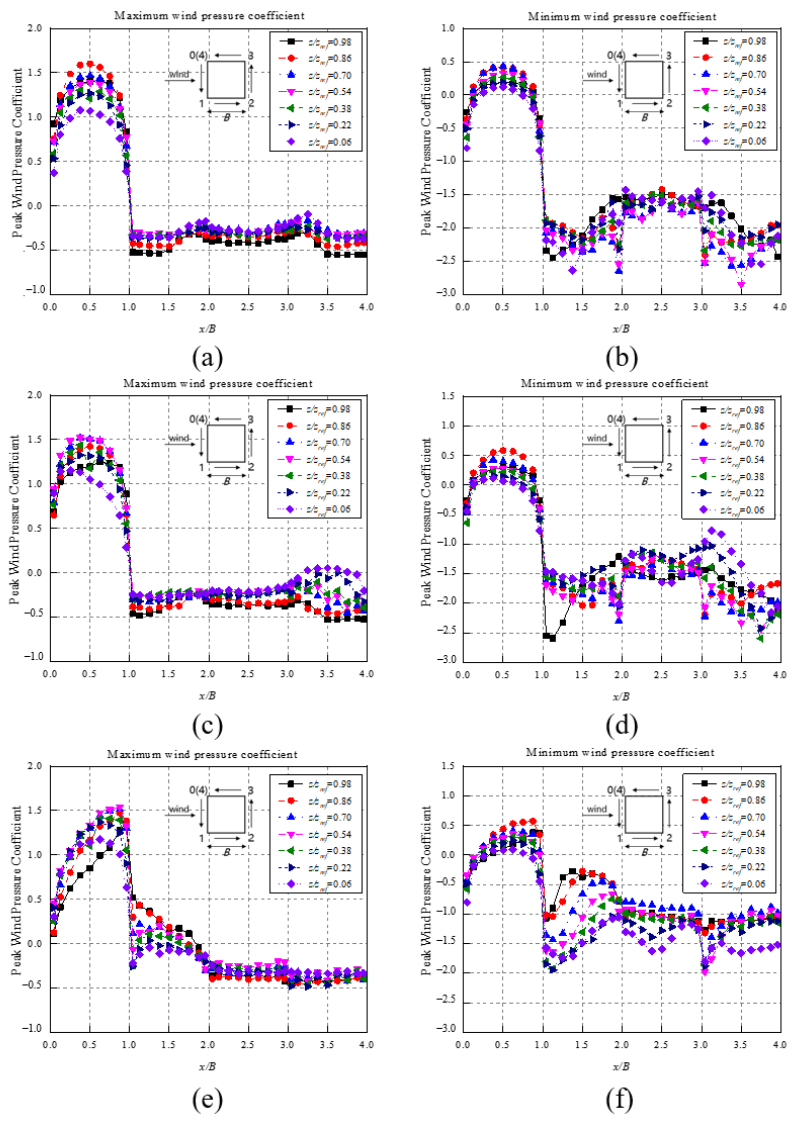
Figure 11. Distributions of peak pressure coefficients: ( a , b ) CWF1-0°; ( c , d ) TWF30-0°; and ( e , f ) TWF30-30°.